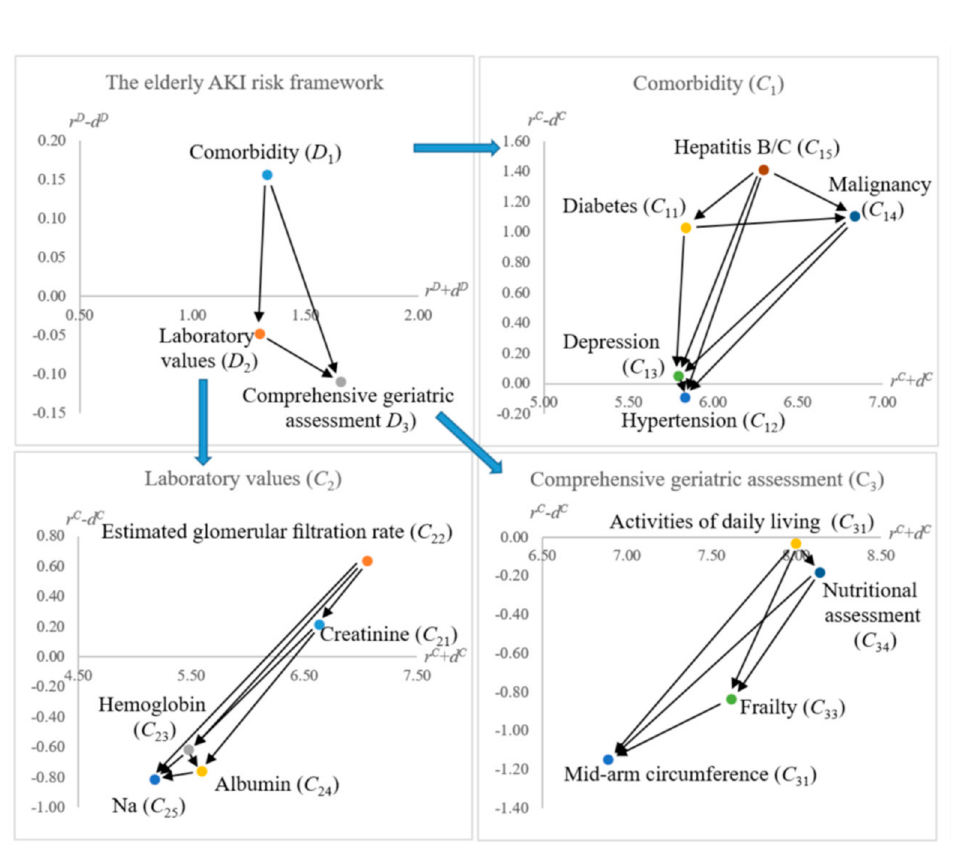
Figure 2. Internetwork relationship map